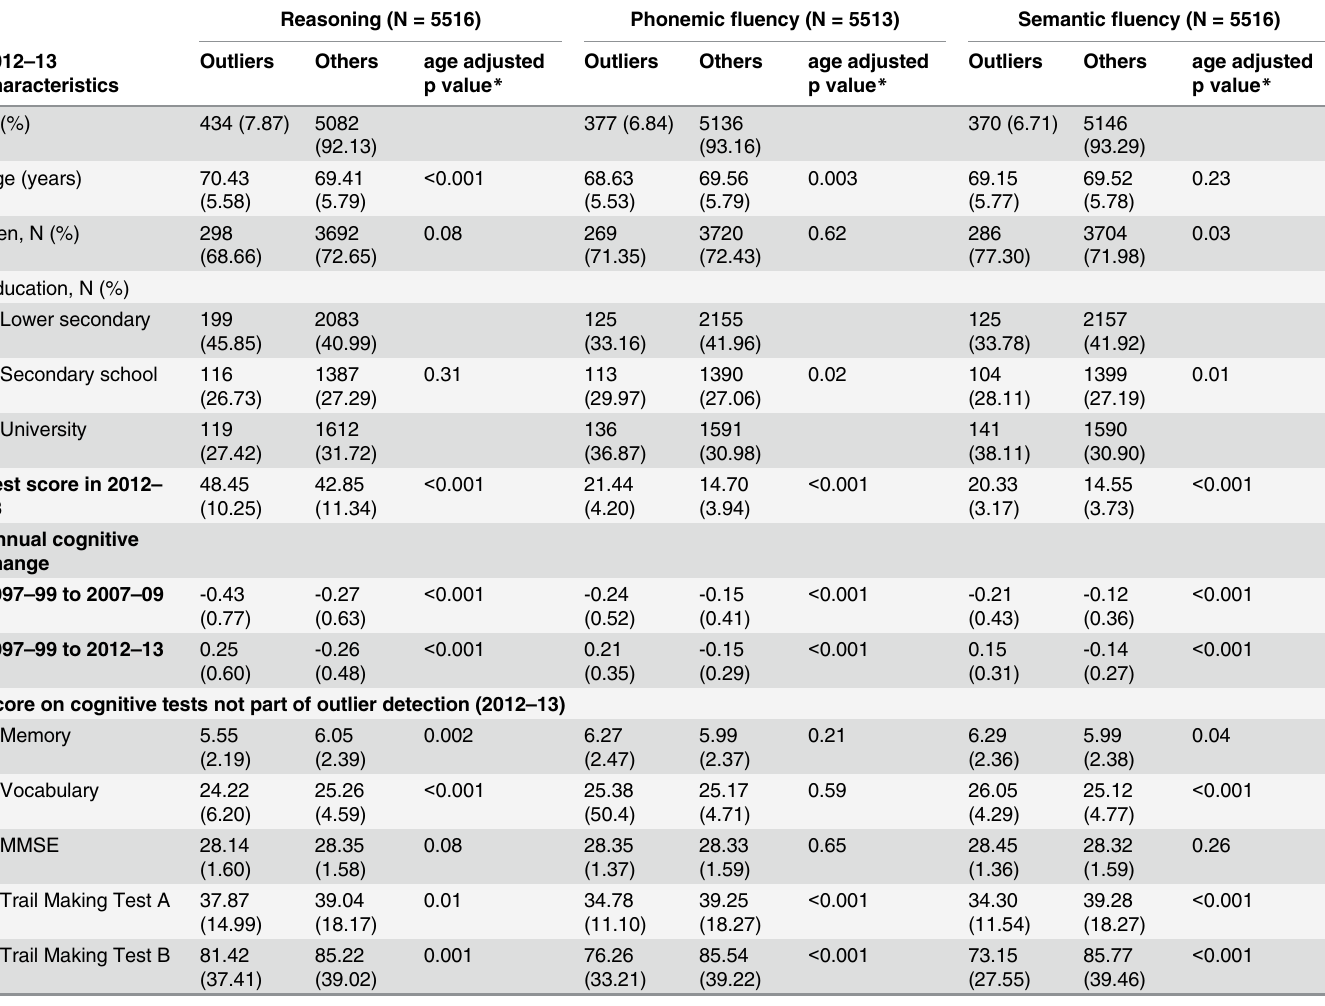
Table 3. Characteristics of outliers compared to others assessed at the clinic in 2012 – 13.